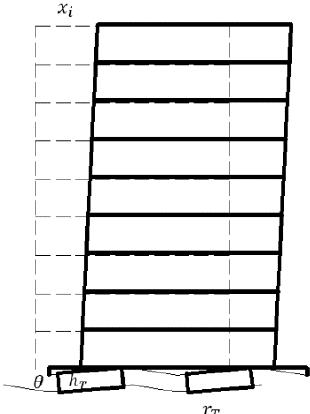
Figure 5. Isolation structure equipped with SLDTFPB.